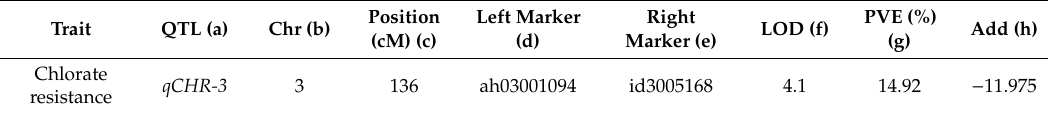
Table 1. Quantitative Trait Locus (QTL) associated with chlorate resistance in rice.